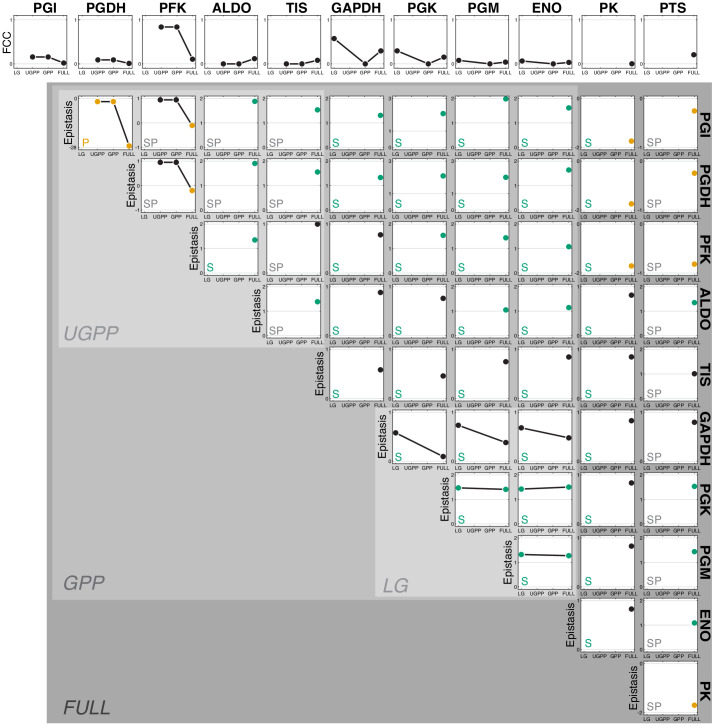
Control and epistasis coefficients for the fluxes through multiple sub-modules within glycolysis.The top row shows the FCCs of 11 reactions whose FCCs in the FULL model are positive (see Figure 5—figure supplement 2). The matrix below shows the epistasis coefficients for each pair of these reactions. The topological relationship between reactions is indicated in the lower left corner of each panel ('P', strictly parallel; 'S', strictly serial; 'SP' serial-parallel). Points are colored orange (green) if the epistasis coefficient is less than zero (greater than one). Backgrounds of different shades of gray indicate the sub-modules, as in Figure 5—figure supplement 1.